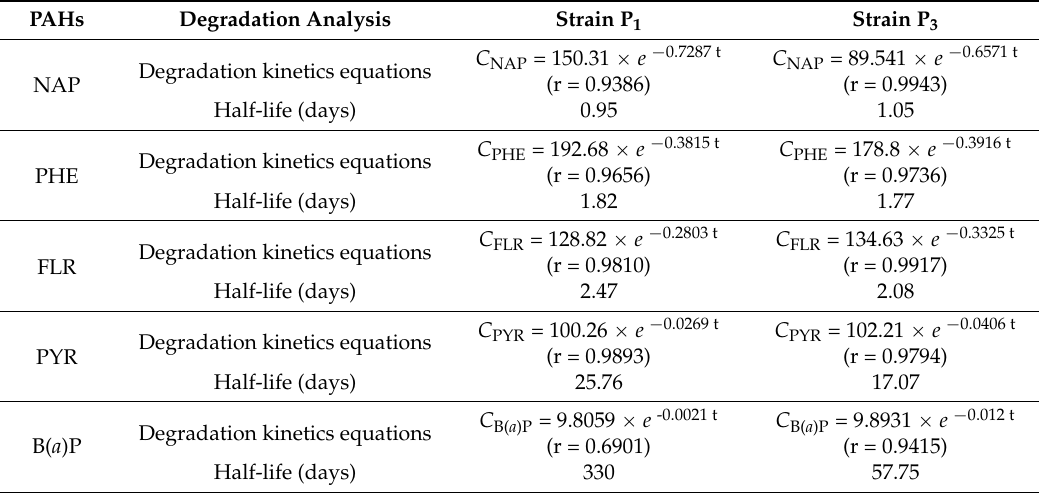
Figure 5. Degradation of PAHs by strains P 1 ( A ) and P 3 ( B ) in medium containing a mixture of PAHs. Table 2. Degradation kinetics equations for PAHs in media supplemented with a mixture of PAHs.